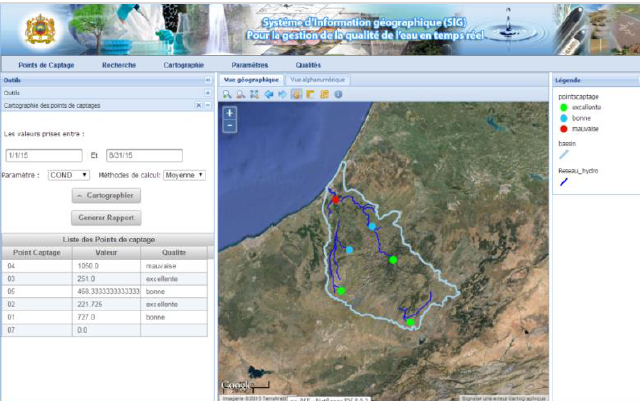
Figure 7. Thematic map of the water